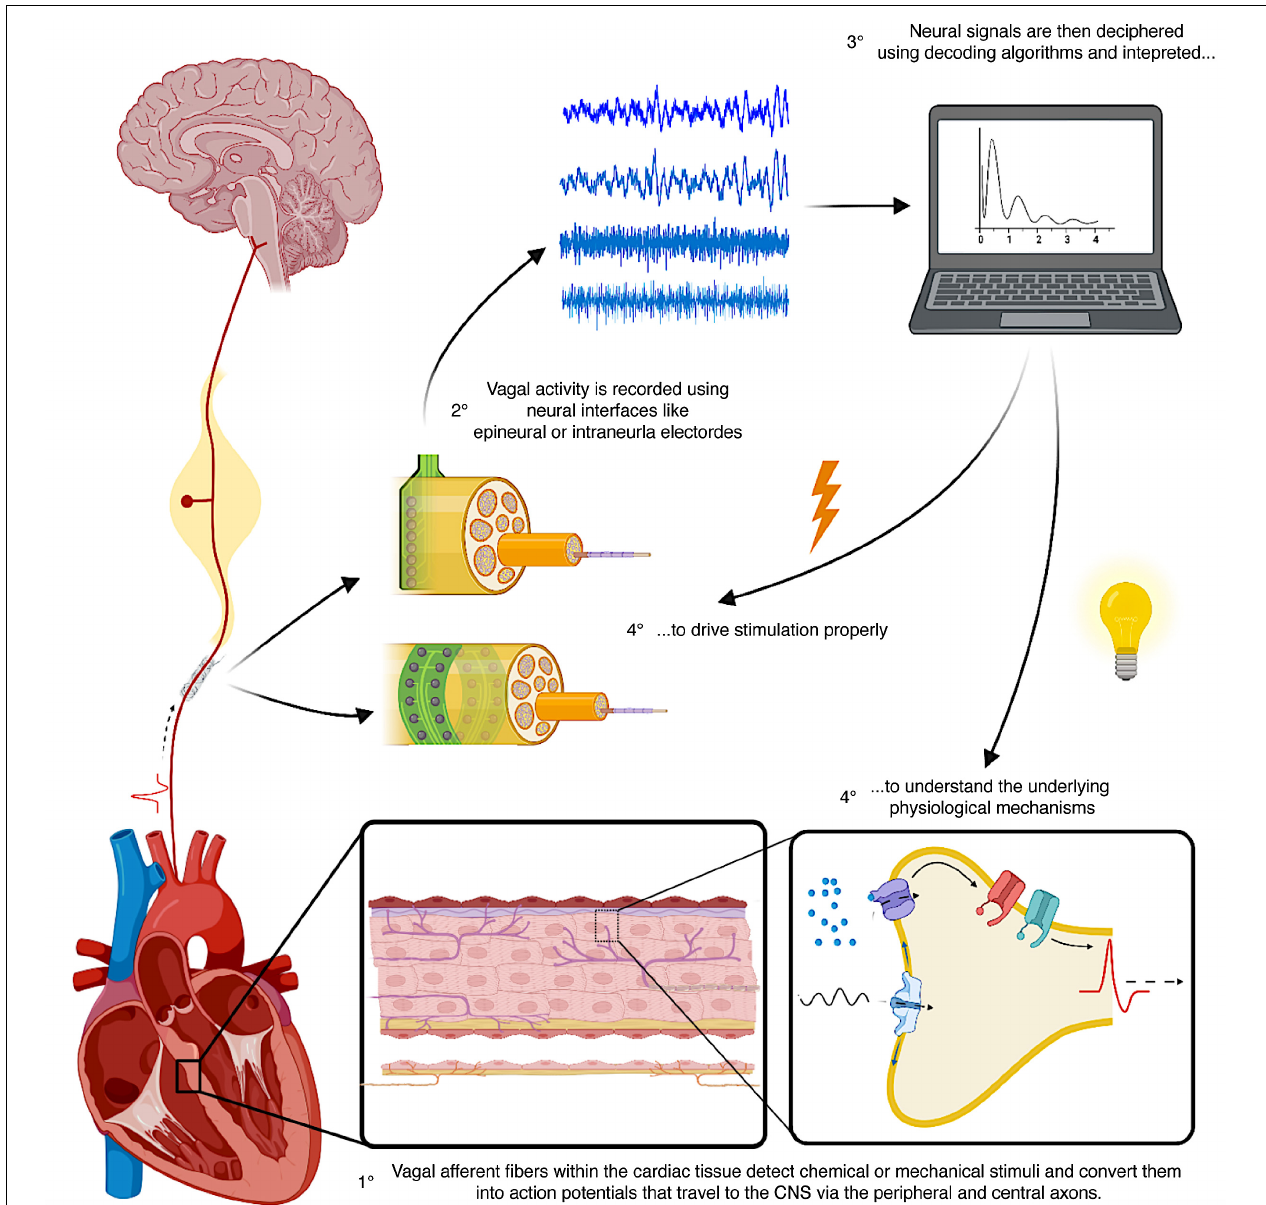
FIGURE 5 | Schematic representation of the principles of closed-loop neuromodulation using neural recordings and decoding strategies. The heart is densely innervated by vagal afferent fibers, which detect chemical and mechanical stimuli, convert them into electrical signals (action potential) and send them to the CNS via their peripheral and central axons. Using neural interfaces placed on the vagus nerve, it is possible to record and decode these electrical signals and identify the underlying physiological processes and set the spatiotemporal characteristics of stimulation. CNS, central nervous system.